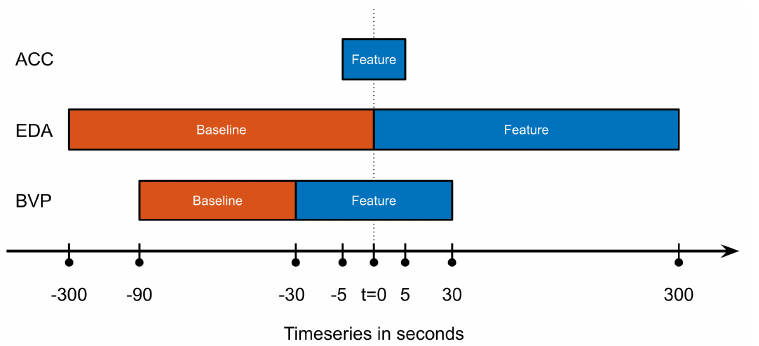
Figure 1. Overview of how the feature and baseline windows were chosen, for the three different groups of features by modality. This calculation would result in one feature vector, for the next the windows would all be shifted by an interval of T = 2 s to the right. Abscissa not to